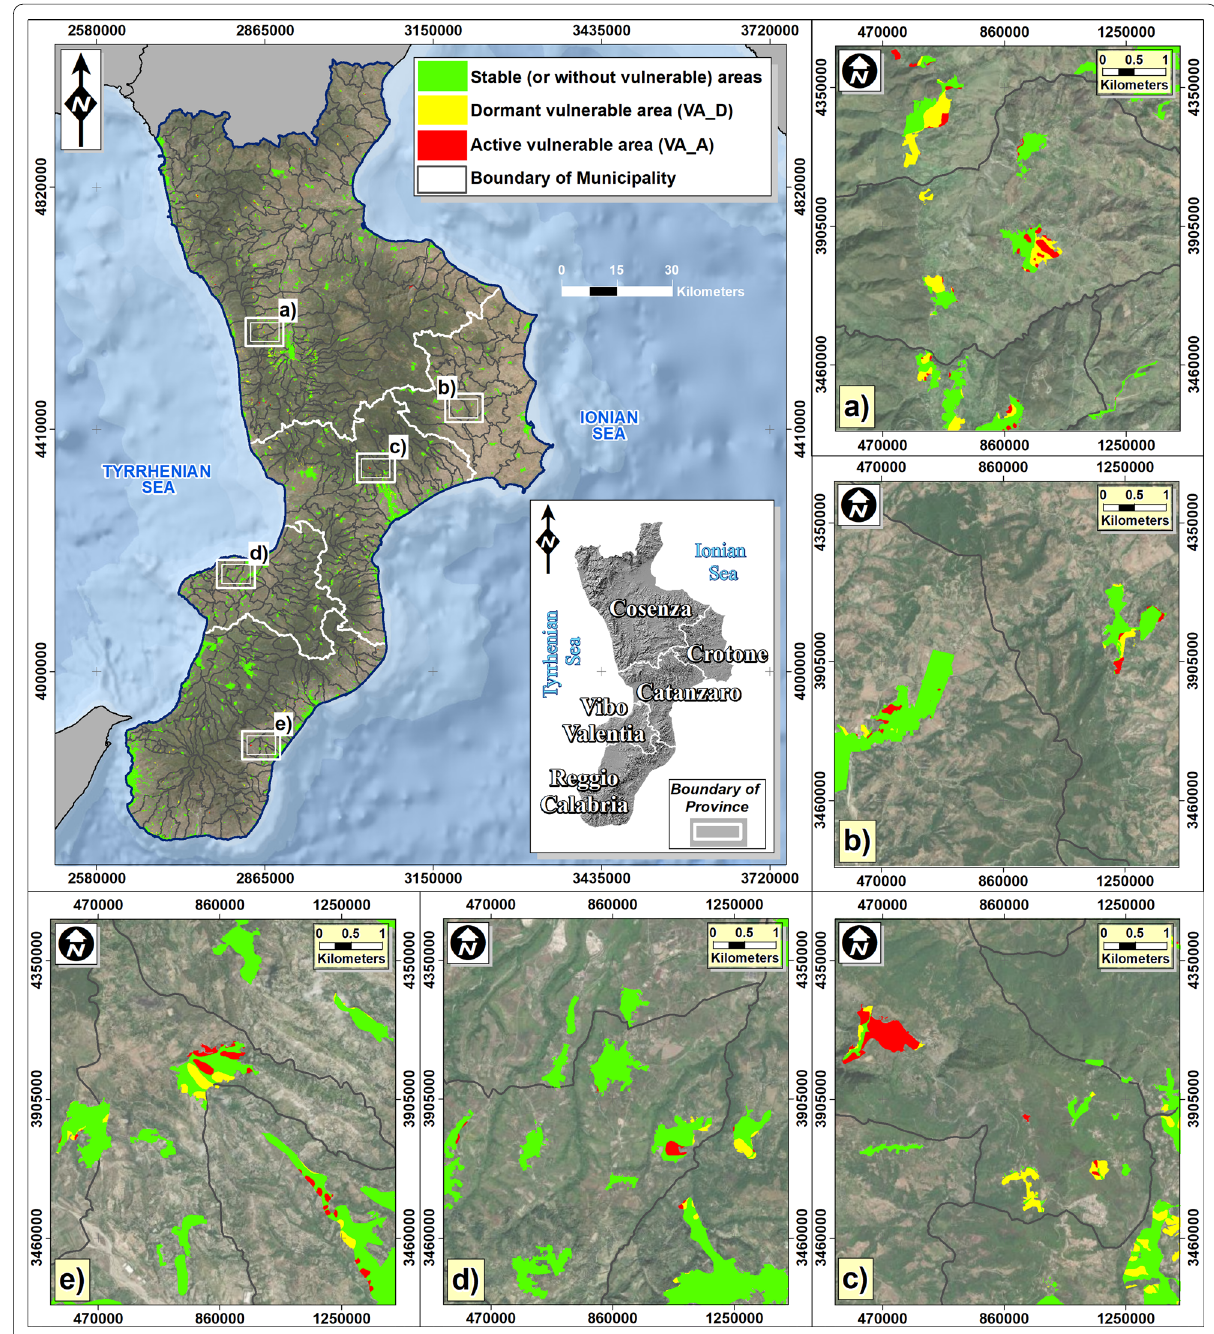
Fig. 8 A general overview of built-up areas of Calabria Region distinguished in either stable (or without VAs) and VAs (the latter are classified as active—VA_A and dormant—VA_D based on the state of activity of the slow-moving landslides interacting with them). The maps show some samples of built-up areas (white boxes) falling within the administrative boundaries of the five Provinces in the Calabria region: a Cosenza, b Crotone, c Catanzaro, d Vibo Valentia and e Reggio